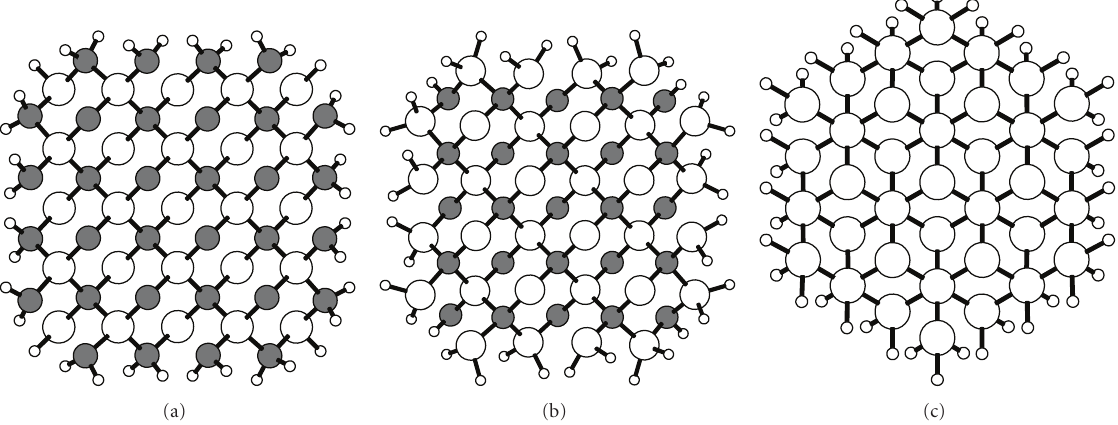
Figure 1: Cross-section view of the structural models of (a) C-coated [100] SiC NW, (b) Si-coated [100] SiC NW, and (c) [111] SiC NW. Carbon, silicon, and hydrogen atoms are represented by filled, empty, and small-empty circles,